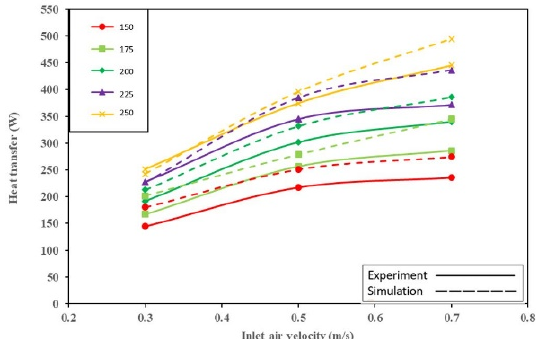
Figure 12. Heat transfer capacity comparison between experimental and numerical results for the condenser end of the heat exchanger.